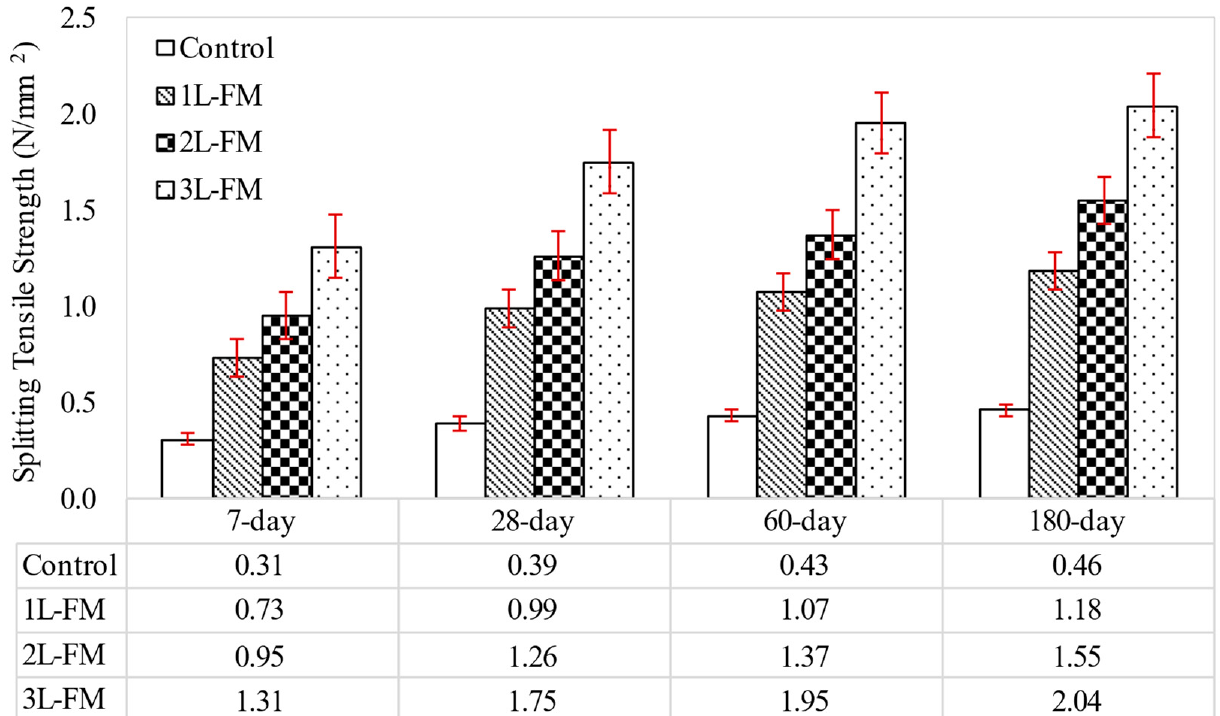
Figure 9. Splitting tensile strength of foamcrete with different layers of FM.